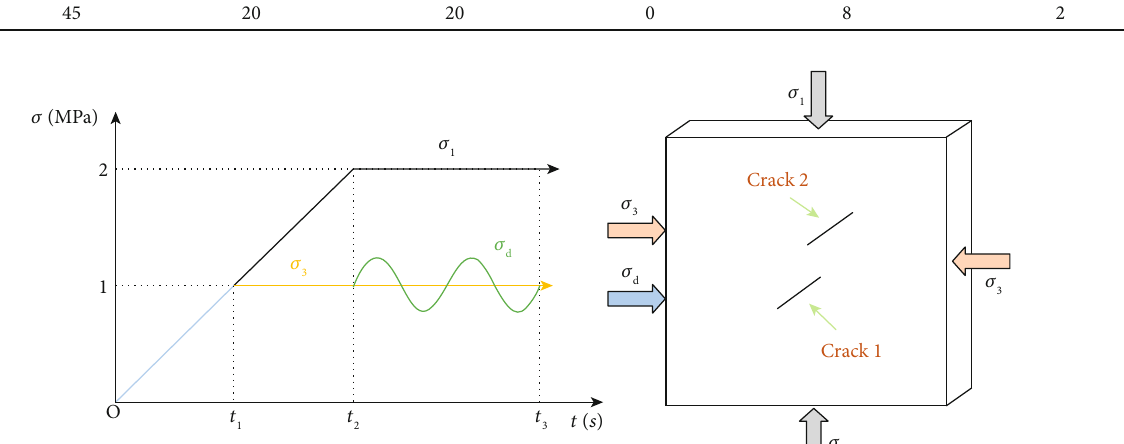
Figure 13: Sketch of the calculation stress path.